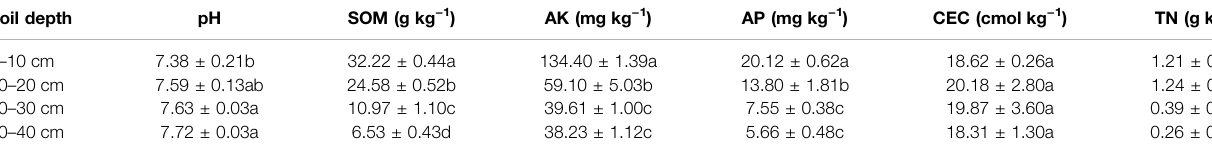
TABLE 1 | Basic characteristics of the pro fi le (0 – 40 cm) soils fi lled in column in the present study. Soil